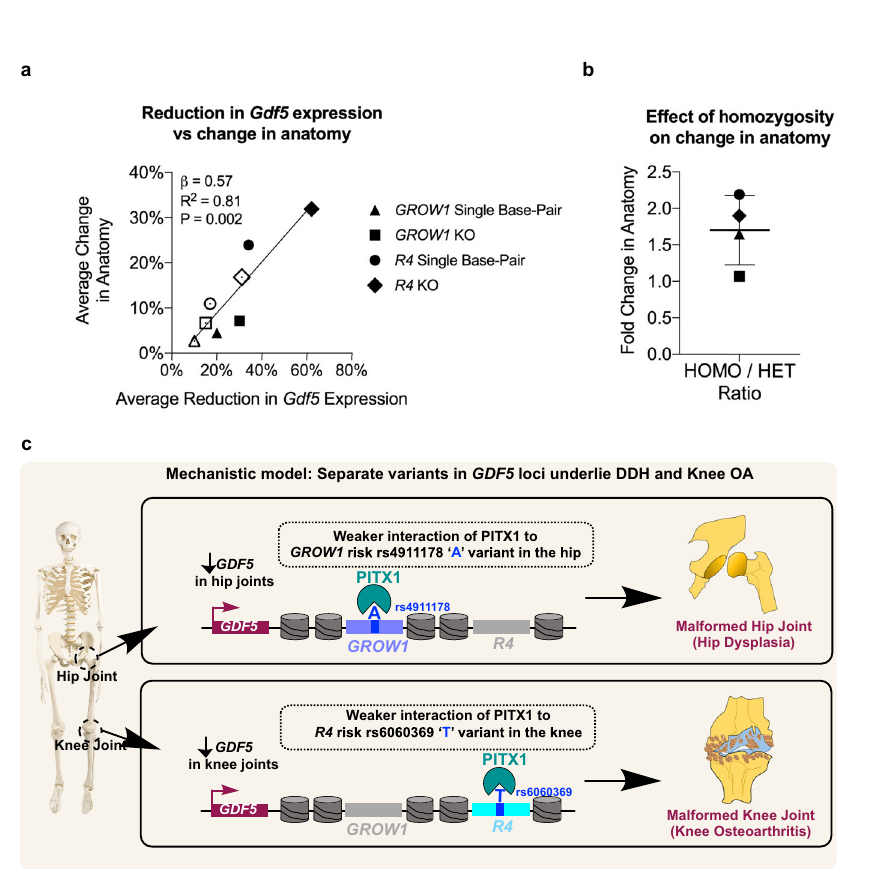
Fig. 5 Association between GDF5 expression and phenotype severity. a Linear regression analysis showing a strong linear relationship between levels of Gdf5 expression and extent of bony shape changes in four distinct mouse lines, two of which harbor separate enhancer deletions (i.e., of R4 and GROW1 ) and two of which harbor separate, single-base-pair replacements in these enhancers (i.e., at rs6060369 and rs4911178). Dark circles = homozygous, open circles = heterozygous. See the Supplementary Information for related analyses. b Average fold change in anatomy between homozygous and heterozygous (enhancer null and single base-pair) mutations in R4 and GROW1 enhancers. Summary data are presented as mean and standard deviations. c Mechanistic model showing two separate non-coding regulatory variants on the same risk GDF5 haplotype, i.e., rs4911178 “ A ” variant in the GROW1 enhancer and rs6060369 “ T ” variant in the R4 enhancer control different pathologies (i.e., DDH and knee OA, respectively) in different joints, mediated by differential binding of PITX1 on each respective enhancer variant in each speci fi c